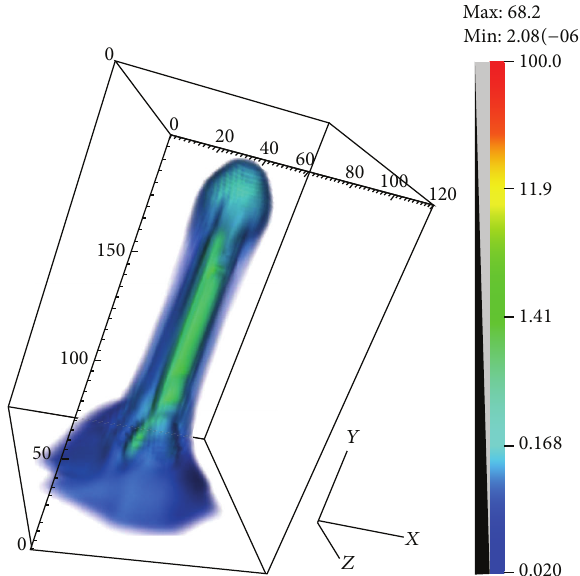
Figure 2: A plot of the magnetic field magnitude roughly half way into the simulation. We can see the jet self-confinement due to magnetic forces resulting in a narrow